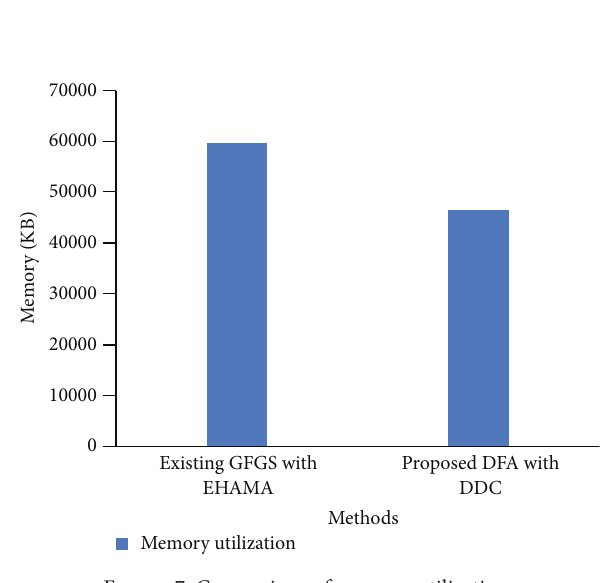
Figure 7: Comparison of memory utilization.